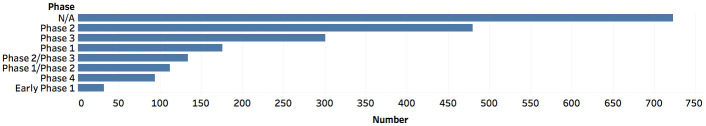
Phase information including phase 0, the FDA defines a five phase process for approving new drugs [14].This graph shows the phases for COVID-19 related clinical trials.